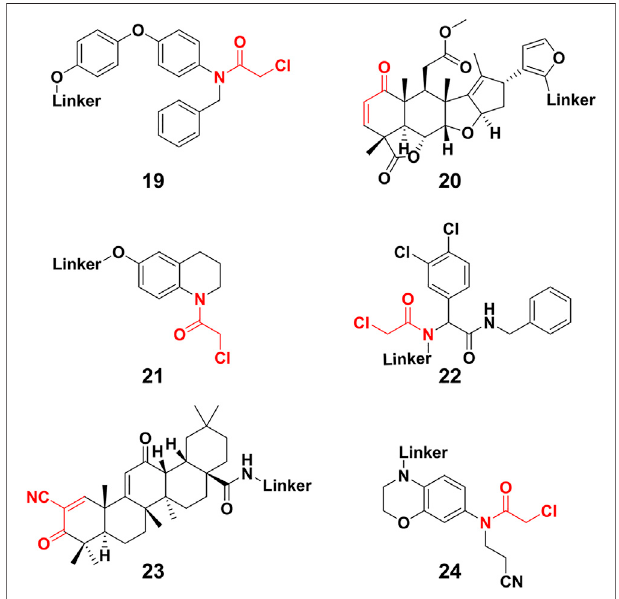
FIGURE 7 | Chemical structure of novel E3 ligase ligand for covalent PROTACs.